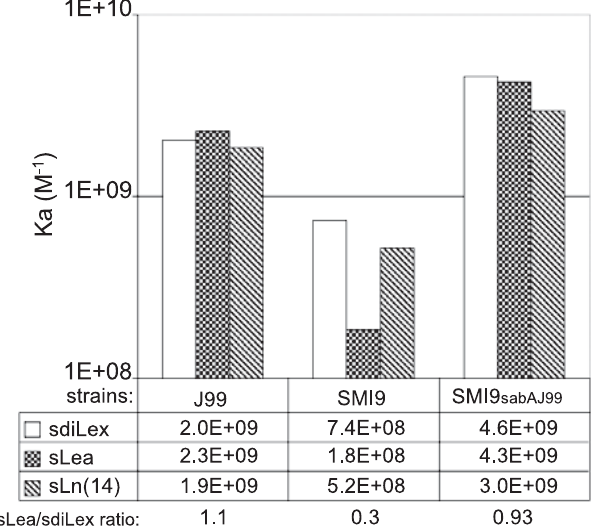
Figure 6. Analyses of SabA-Dependent Binding among Clinical Isolates (A) Binding characteristics of H. pylori clinical isolates and SabA-deficient isogenic mutants were studied by use of soluble 125 I-labeled sdiLex, sLea, and sLn(14) conjugates. (B) Immunoblot analysis of H. pylori clinical isolates and mutant strains using SabA antibodies. There were no SabA bands detected among the sabA deletion mutants; actually, there were no additional bands on the blots. DOI: 10.1371/journal.ppat.0020110.g006